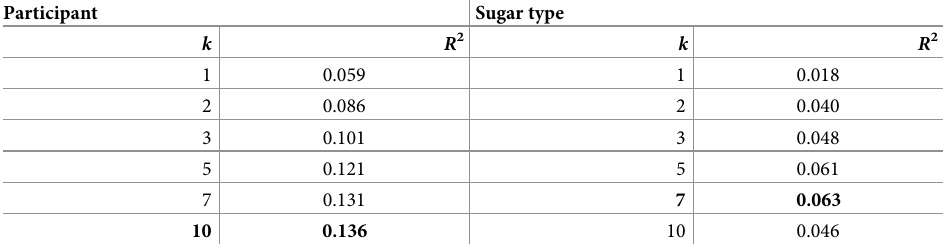
Table 1. Fraction of variance explained by participant (left table) or sugar type (right table) for EKS distances with a range of values of k . Samples were embedded using CMDS and the EKS distance for the specified value of k , and MANOVA was used to compute the fraction of variance of the embedded points explained by participant or sugar type. The distance corresponding to the largest fraction of variance explained is highlighted in each table.